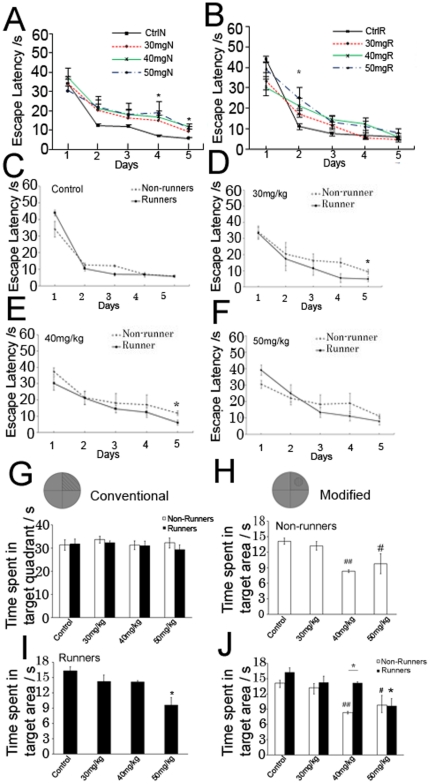
Performance in water maze task of CORT-treated non-runners and runners.(A) Non-runners treated with 30 mg/kg, 40 mg/kg and 50 mg/kg CORT showed impairment in spatial learning. (B) Runners with 50 mg/kg CORT treatment showed impairment in spatial learning compared to vehicle-treated runners. *P<0.05 compared to control. (C–E) Runners treated with 30 mg/kg and 40 mg/kg CORT showed significantly shorter escape latency compared to non-runner counterparts indicating improved spatial learning. (F) Running did not improve spatial learning in 50 mg/kg CORT-treated rats. *P<0.05 compared to non-runner conterparts. Data were analysed using conventional method in (G) and modified scoring method in (H–J). (G) There was no significant difference among groups using conventional method. (H) In the modified method, 40 mg/kg and 50 mg/kg CORT-treated non-runners showed a shorter time spent in target area compared with control non-runners. (I) Runners treated with 50 mg/kg CORT showed impairment in spatial learning compared to control runners. (J) This graph was a combination of (H) and (I) for representing the comparison between non-runners and runners. Running increased time spent in the target area in 40 mg/kg CORT-treated runners, but not in 50 mg/kg CORT-treated runners compared with non-runner counterparts. #P<0.05, ##P<0.005 compared to vehicle-treated non-runners. * P<0.05 compared to vehicle-treated runners. N = 8-10/group.